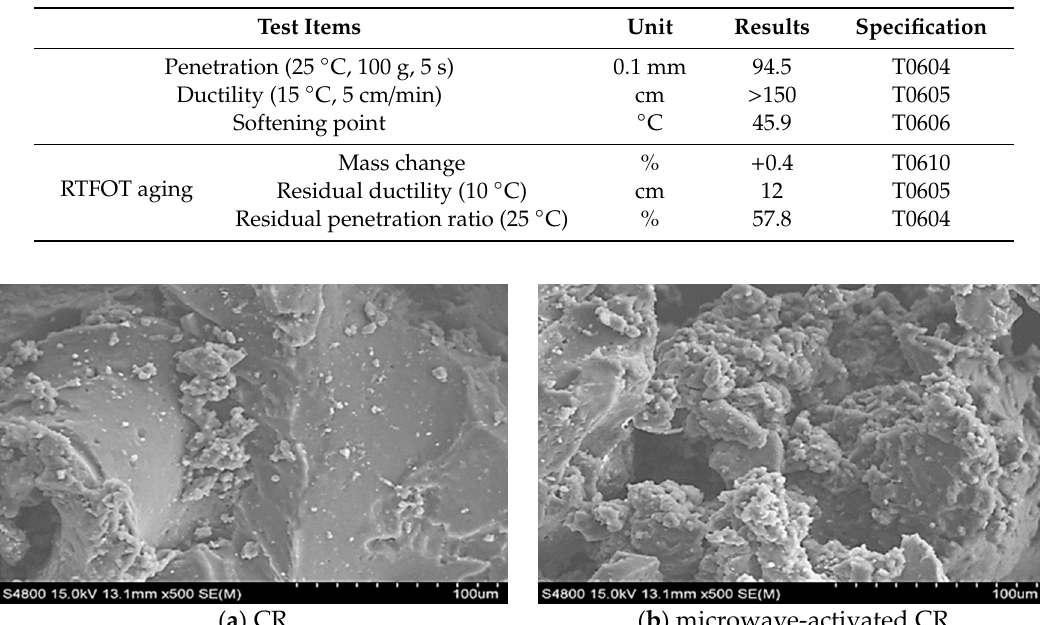
Table 2. Details and labels of different rubberized bitumen samples.